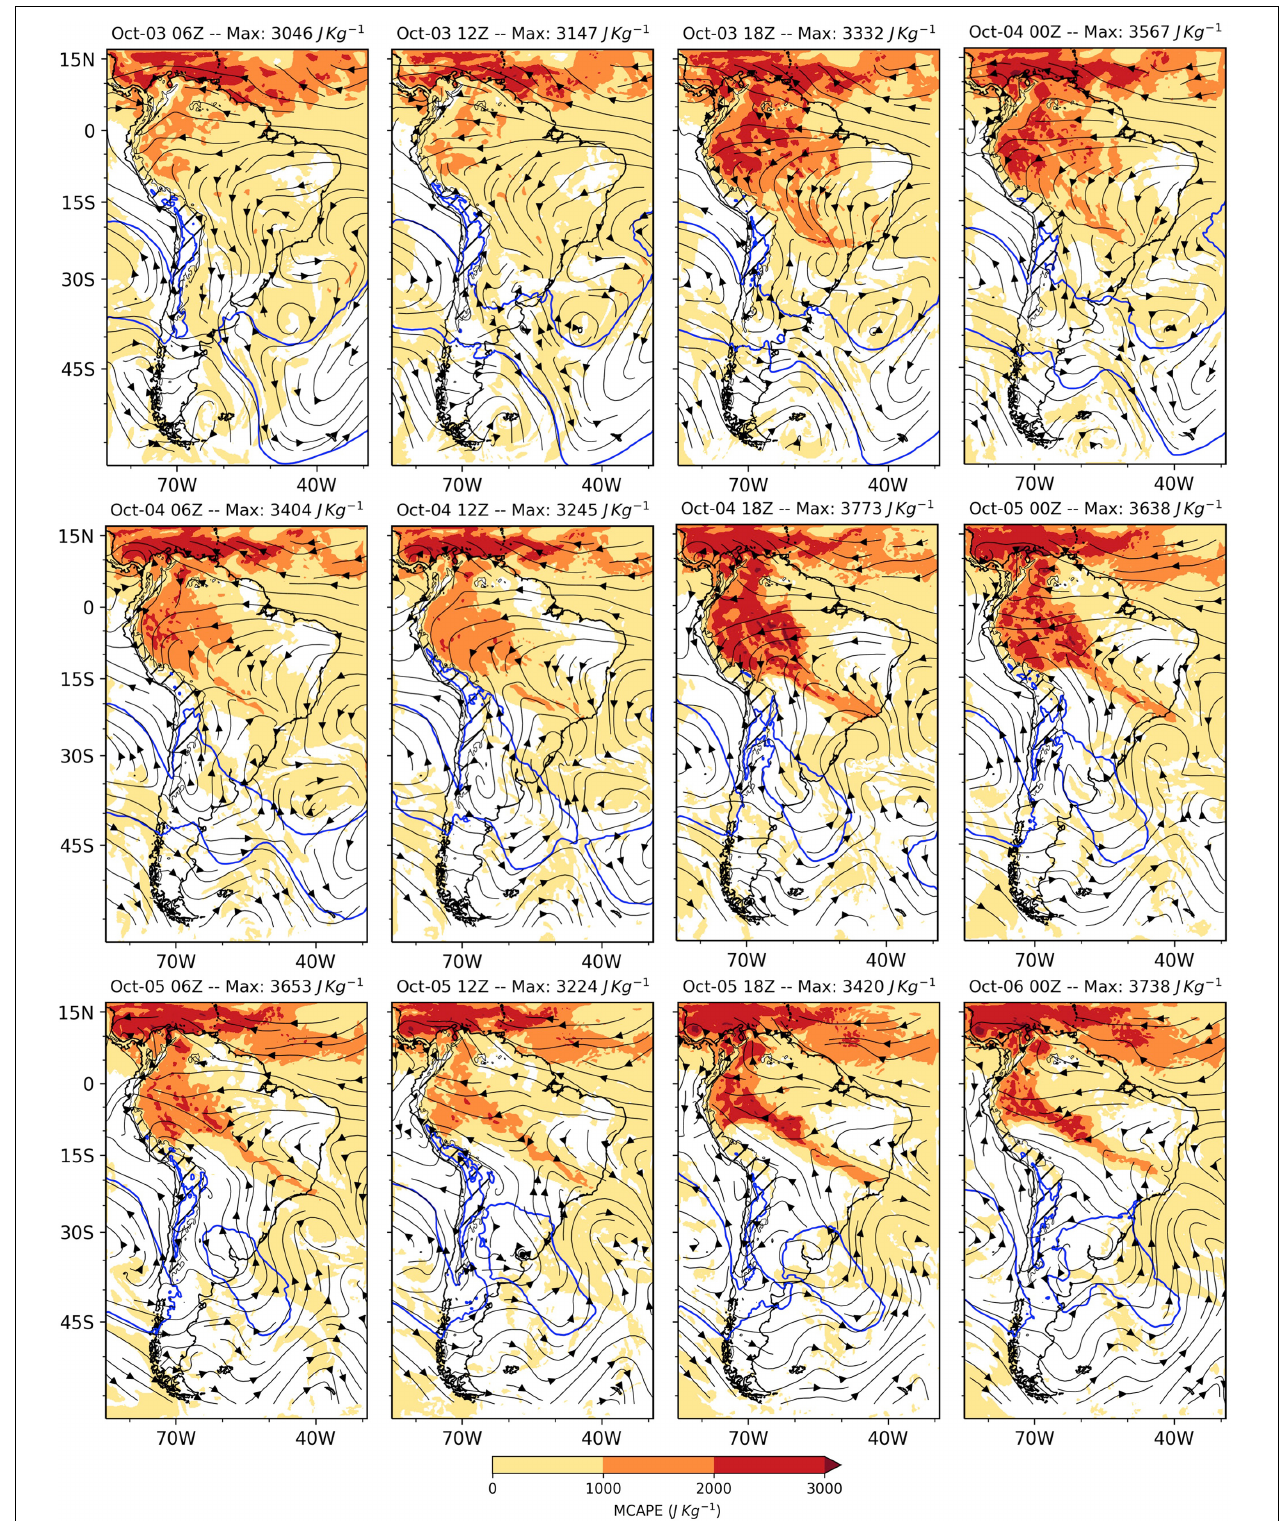
FIGURE 4 | WRF simulation (D01, 18 km) of the CAI case from October 3 00Z to 6 00Z, 2013. The maps show the evolution of the MCAPE in the lower 3,000 m during the simulation. The streamlines show the 850 hPa horizontal wind and the blue contours delineate the 1,020 hPa sea level pressure.